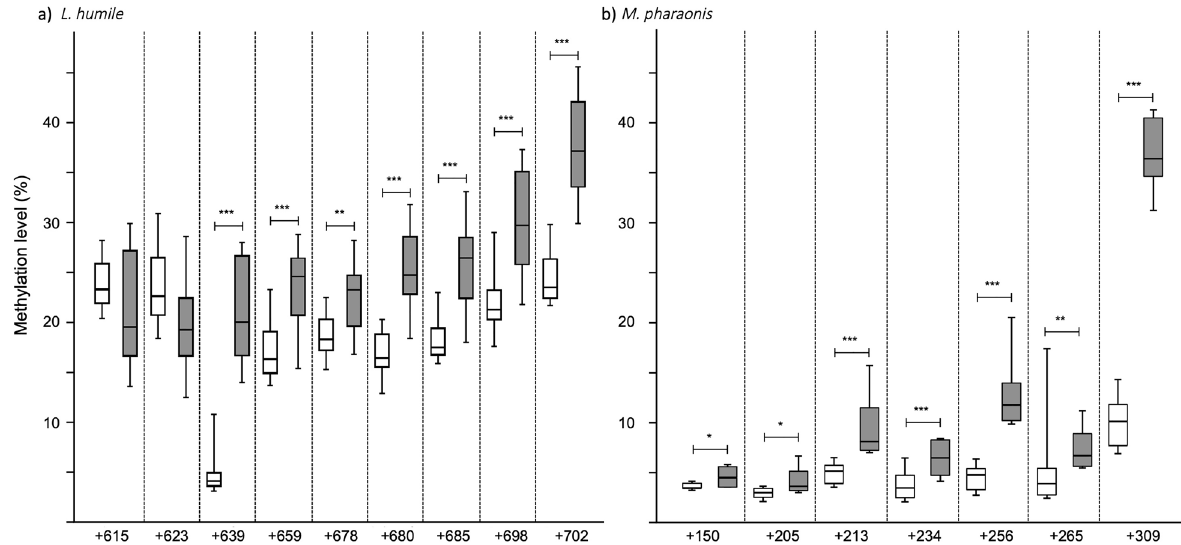
Figure 3. Effect of 5-Aza-dC treatment on egfr methylation. Box plots of egfr CpG methylation levels for ( a ) Linepithema humile and ( b ) Monomorium pharaonis prepupae fed a control solution (1 M sucrose; in white) or 5-Aza-dC (in gray) when they were first-instar larvae. The CpGs are numbered from the beginning of the last exon for each species. Each box represents data for at least 8 samples; each sample was a pool of 10 prepupae. The box’s midline indicates the median; the box’s lower and upper edges are the first and third quartiles, respectively. The whiskers reflect the extreme values. Significant differences between the control and 5-Aza-dC- treated groups are indicated: * p < 0.05, ** p < 0.01, *** p < 0.005 (Student’s t test or Mann–Whitney U